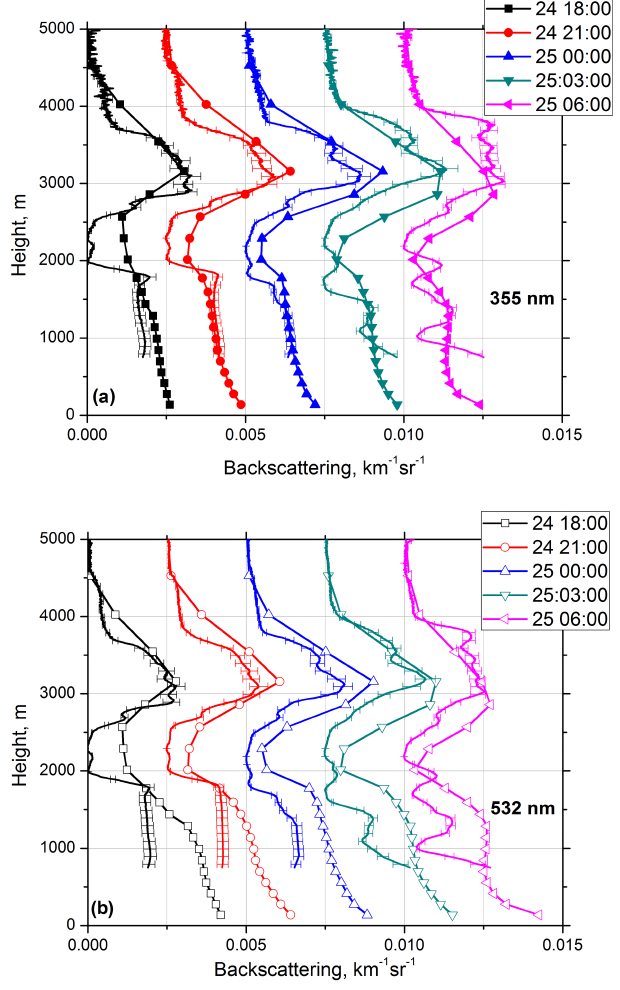
Figure 15. Backscattering coefficients at (a) 355nm and (b) 532nm measured by Raman lidar (solid line) and modeled by MERRA-2 (line + symbols) on the night of 24–24 December 2015. Profiles are shifted relatively to each other by 0.0025km − 1 sr − 1 . The temporal intervals are the same as in Fig. 13.